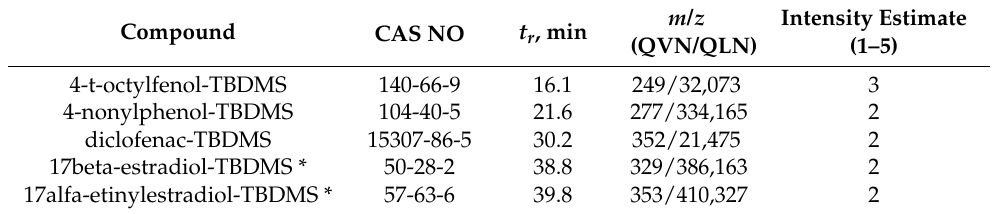
Table 2. Composition of control solution QC5 and results of the analysis for the derivatisation